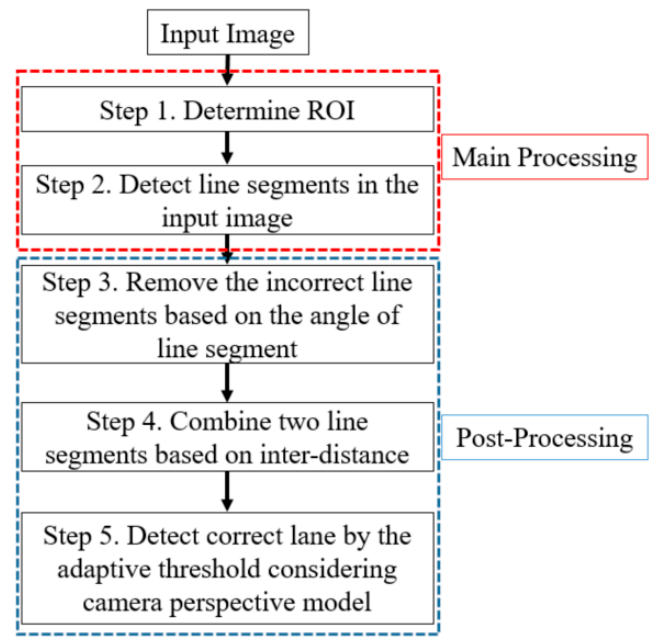
Figure 1. Overall procedure of the proposed method.